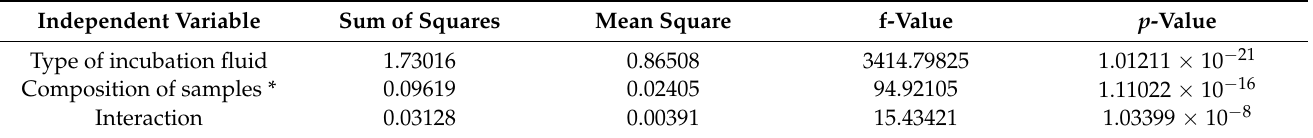
Table 3. Statistical analysis of obtained data based on the two-way analysis of variance (ANOVA) with